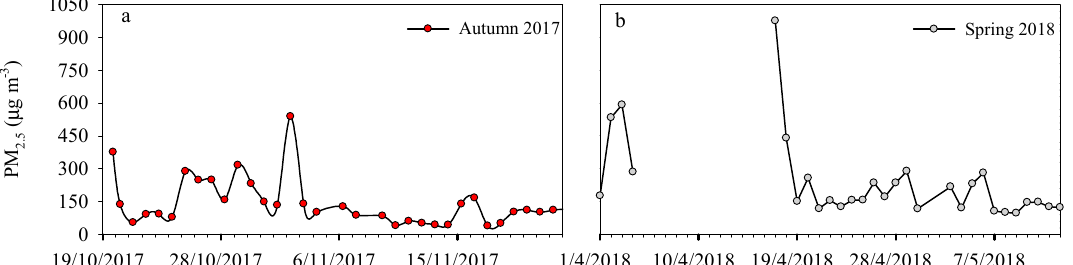
Figure 2. Temporal variation of the mass concentrations of particulate matter with a diameter of less than 2.5 μ m (PM 2.5 ) in autumn 2017 ( a ) and spring 2018 ( b